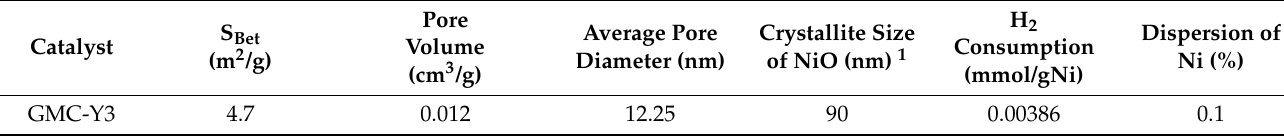
Table 1. Textural properties and H 2 consumption of the GMC-Y3 catalyst.